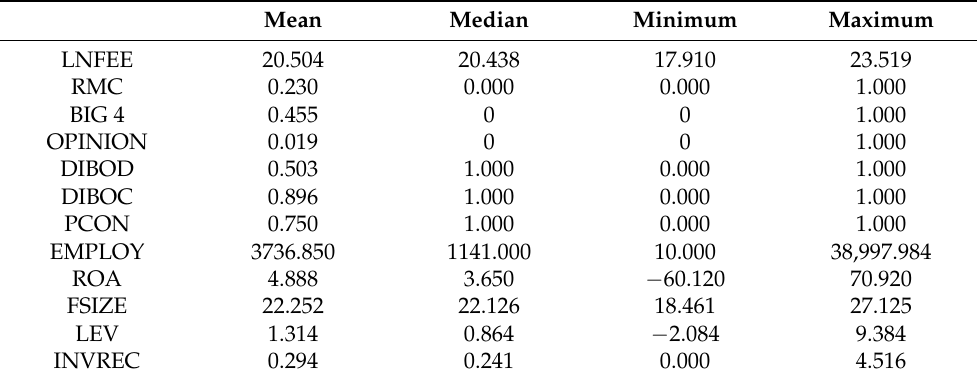
Table 4. Descriptive statistics.